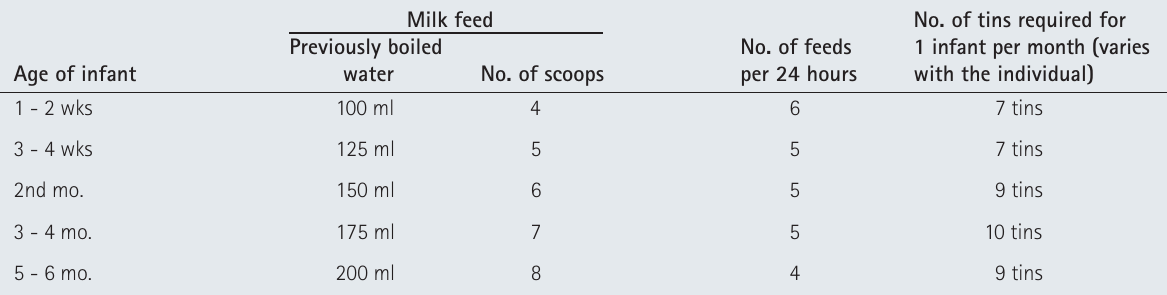
TABle 4.IV. AMOUNTs FOR INFANT FeeDING UNTIl 6 MONTHs OF